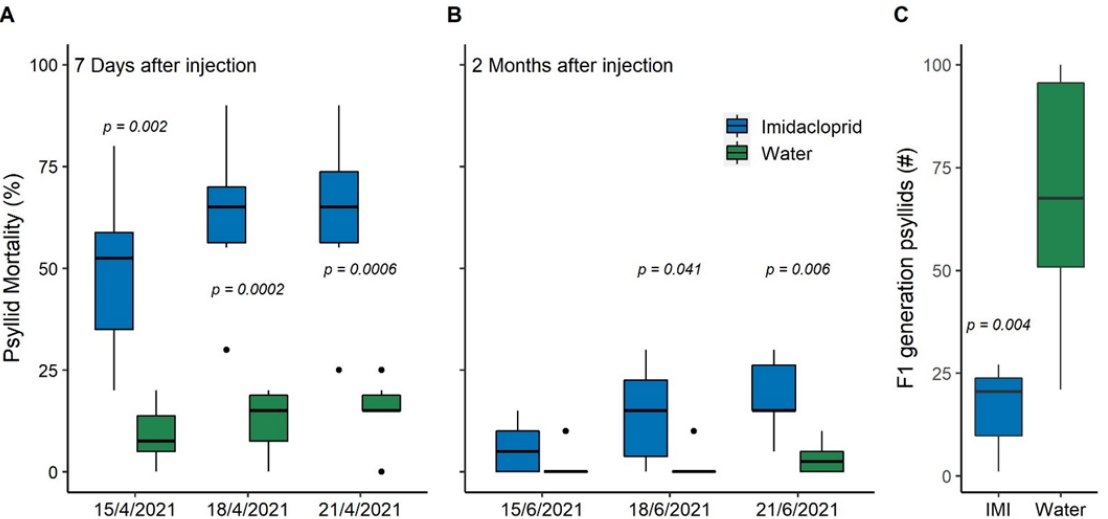
Figure 1. Mortality and survival of greenhouse-reared psyllids after imidacloprid injection in April 2021. Percent psyllid mortality ( A ) one week and ( B ) two months after injection. ( C ) F1 progeny survival on 8 May 2021. P-values indicate where differences are significant ( p < 0.05) for each measurement time.